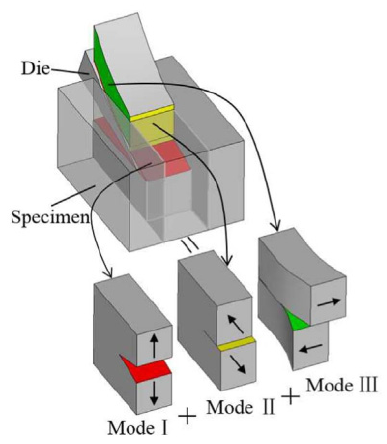
Figure 9. A schematic of mixed fracture modes involved during the cutting process [21].